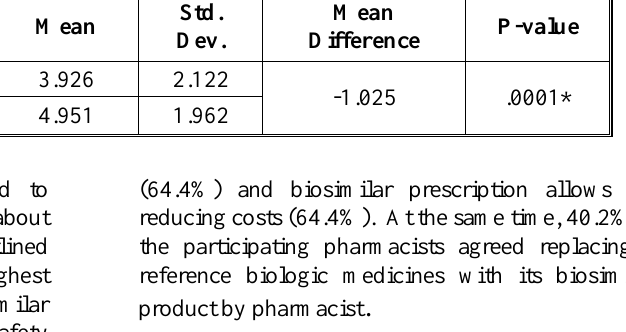
Table 5. The difference between the means of accurate answer scores according to gender. Gender N Mean Female 121 Total score 143 1.962